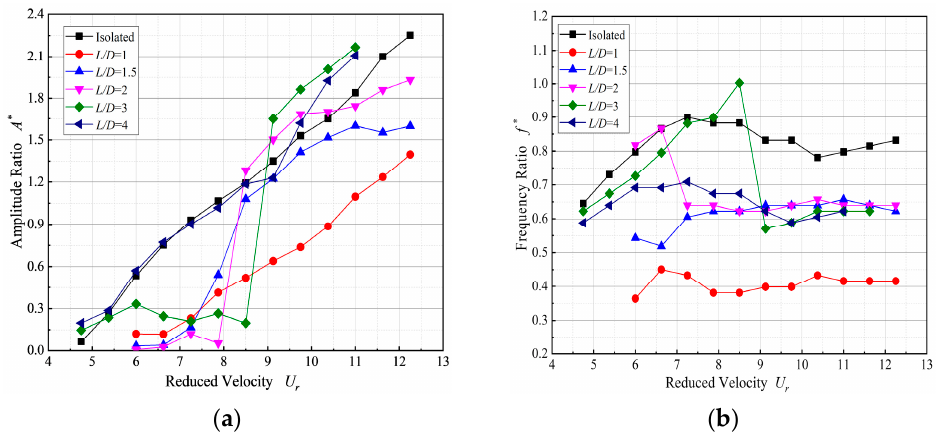
Figure 12. Amplitude ratio and frequency ratio for different gap ratios. ( a ) Amplitude response; ( b ) Frequency response.